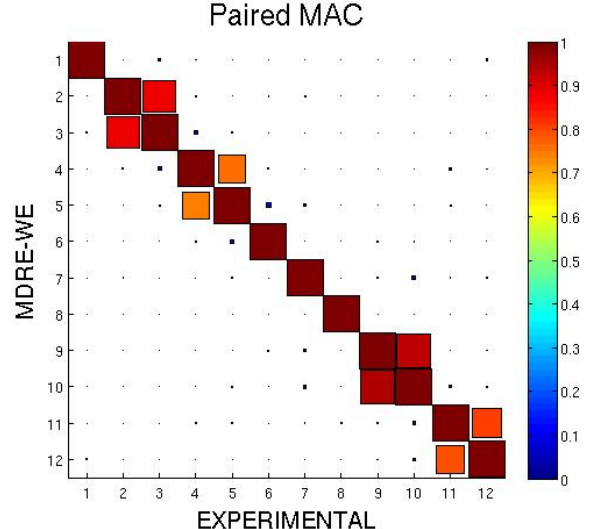
Figure 15: MAC: MSE MDRE-WE vs. Exp.